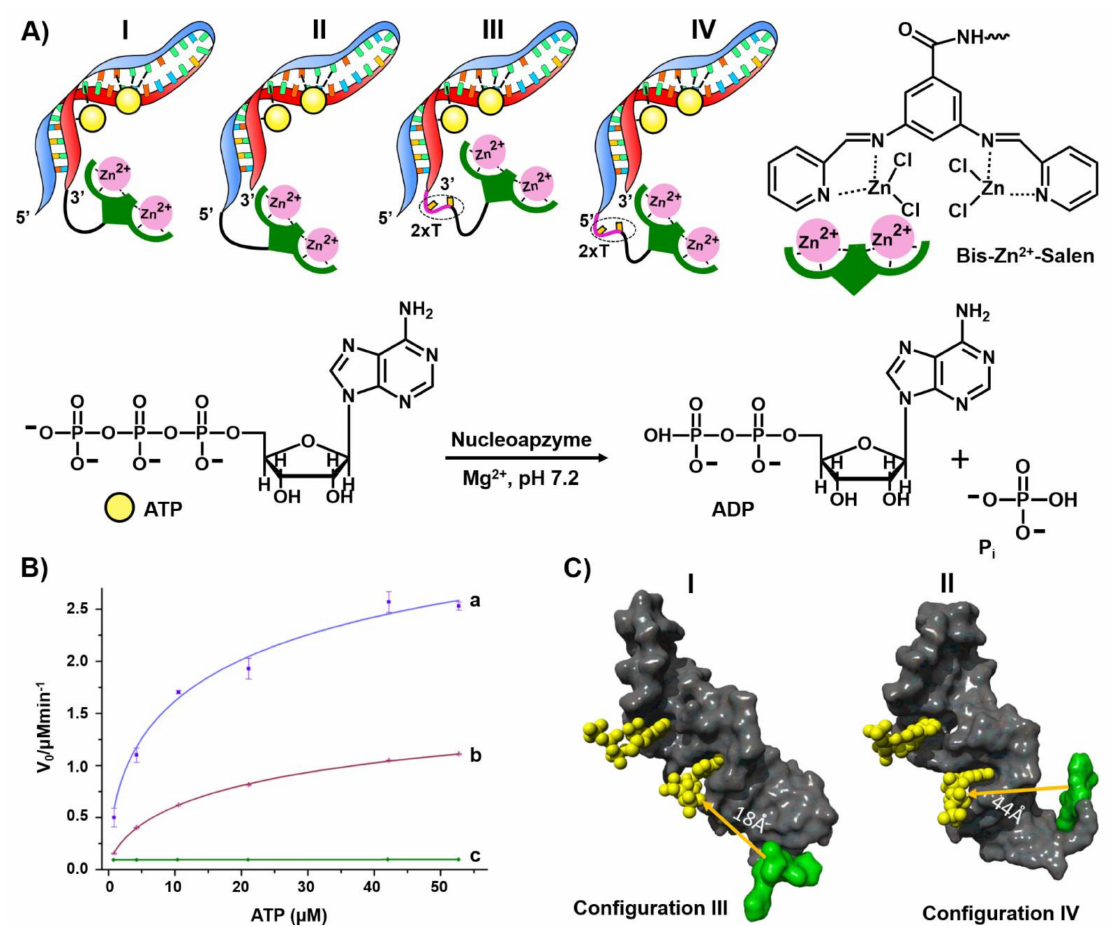
Figure 14. ( A ) Schematic configurations of bis-Zn 2+ -pyridyl salen modified ATP aptamers acting as nucleoapzymes for the catalyzed hydrolysis of ATP to ADP. ( B ) Rates of ATP hydrolysis to ADP by representative nucleoapzymes: a = nucleoapzyme in configuration III; b = nucleoapzyme in configuration IV; c = control experiment using the separated bis-Zn 2+ -pyridyl salen catalyst and the ATP aptamer. ( C ) Molecular dynamics energy-minimized structures of the nu- cleoapzyme in: Configuration III (I) and in Configuration IV (II). Reproduced with permission from ref. [177]. Copyright 2020